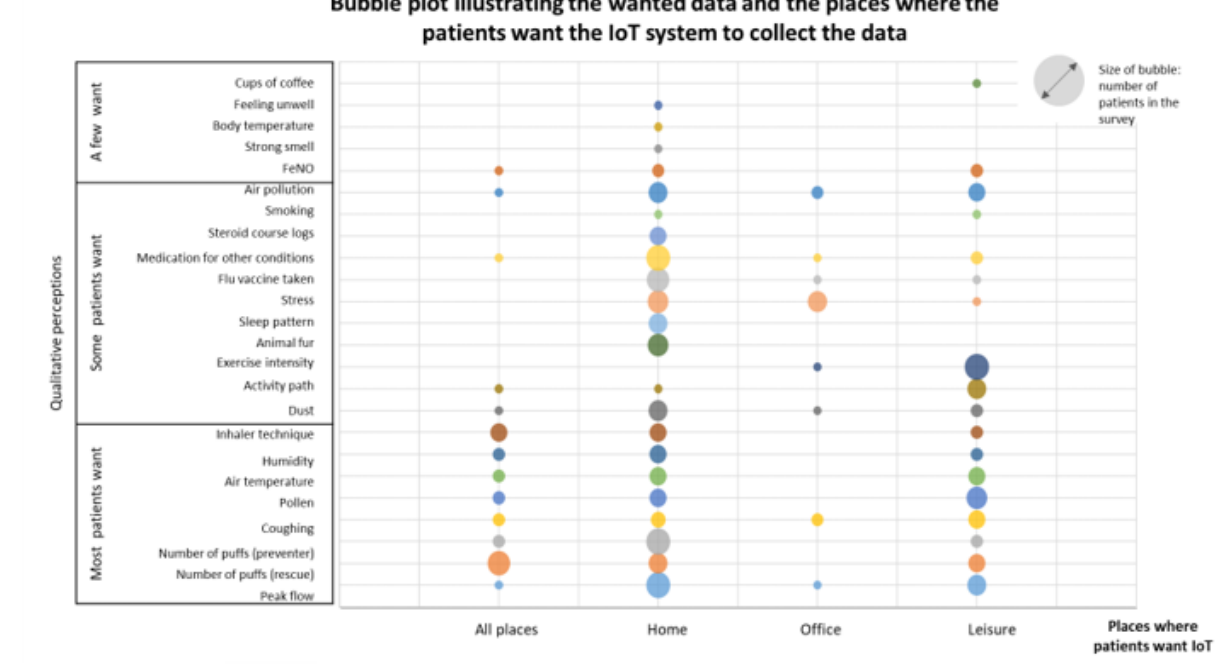
Figure 2. Information that patients want internet-of-things system features to capture. FeNO: fractional exhaled nitric